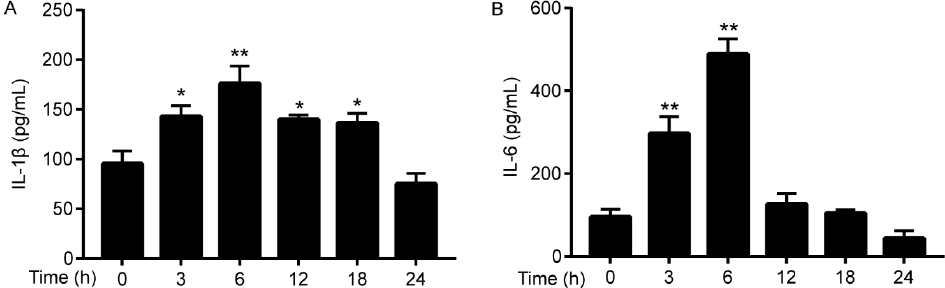
were expressed as means ± SEM ( n = 8). * p < 0.05, ** p < 0.01 compared to control.